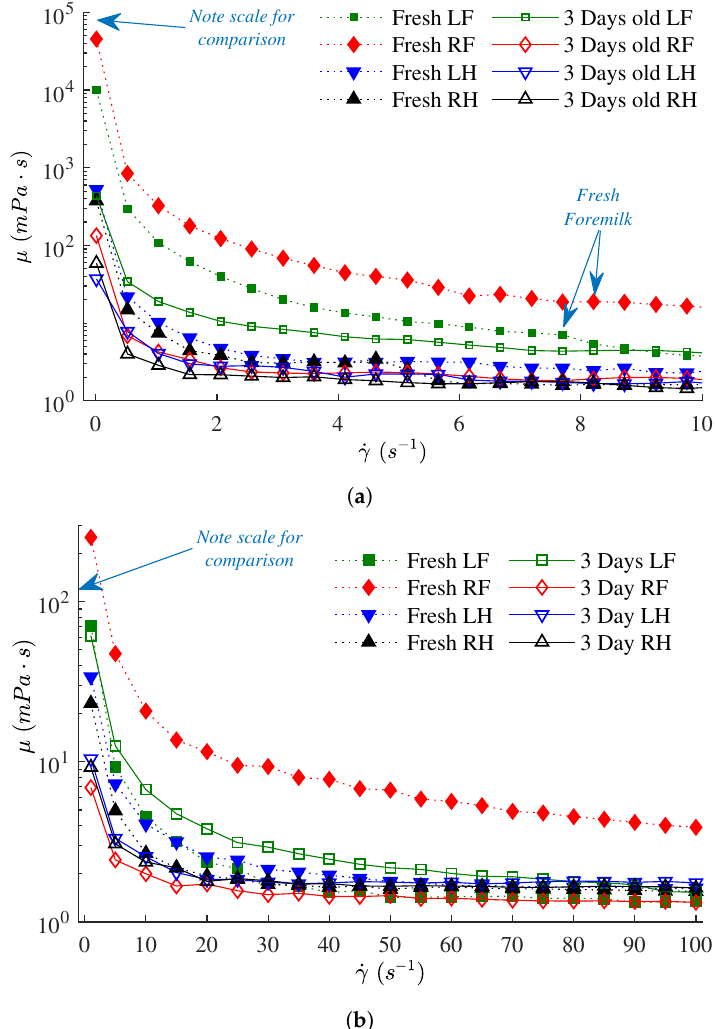
Figure 10. Shear Rate Sweep Tests #2 (Figure 10a) and #1 (Figure 10b) results for milk from Participant #8 show both inter-breast and intra-feed variations in viscosity. Effect of 3 days of refrigeration on milk viscosity associated with intra-individual variations is also seen (discussed in Section 3.5). ( a ) The low shear rates experienced during the beginning and end of a suck cycle show higher viscosity in fresh foremilk (lower fat) compared to hindmilk (higher fat). Storage by refrigeration lowered viscosity of each sample until crossover for foremilk at 8 s − 1 and hindmilk at 6 s − 1 . Inter-breast variations were greater for fresh foremilk than fresh hindmilk and for fresh milk compared to stored milk. ( b ) The starting viscosity (at ˙ γ = 1 s − 1 ) for all fresh samples was higher than after 3 days of refrigeration but that pattern did not continue as shear rate